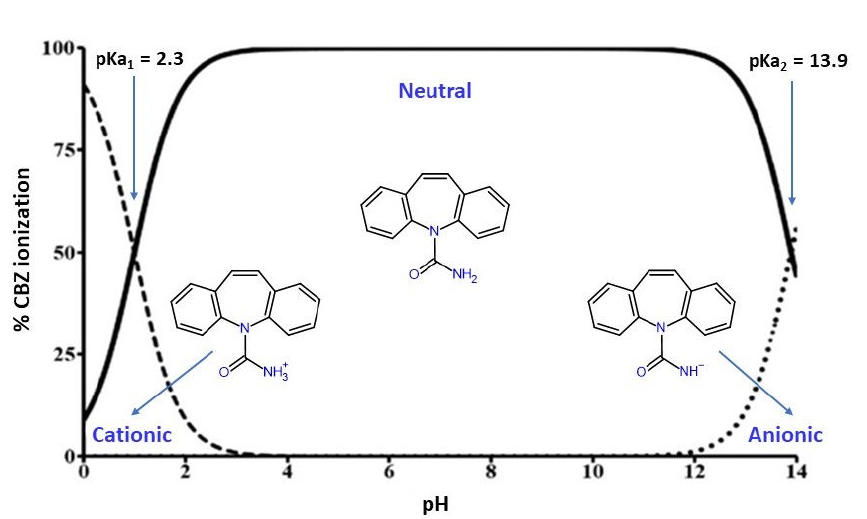
Figure 4. Effect of pH on the removal of CBZ from aqueous solutions (operational conditions: j = 6.67 mA/cm 2 ; distance = 3.5 cm; NaCl = 0.1 M; CBZi = 10 mg/L; reaction time = 10 min; cathode = STS; anode = MMO).